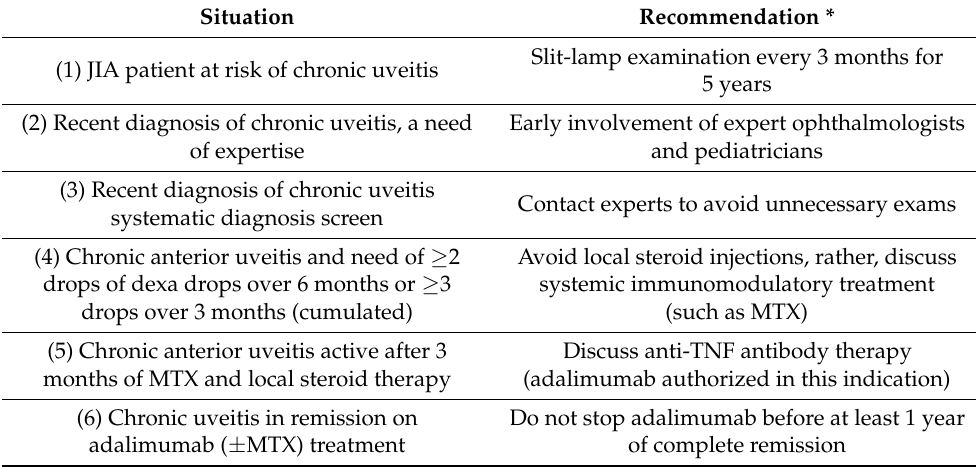
Table 1. Chronic, JIA-associated, non-infectious uveitis: recent key